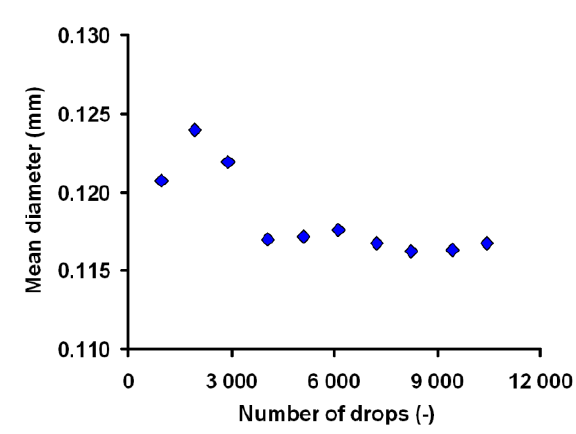
Fig. 4. Determination of minimum number of drops – principle (Rushton turbine, N = 150 rpm). Table 6. Minimum number of drops for evaluation – effect